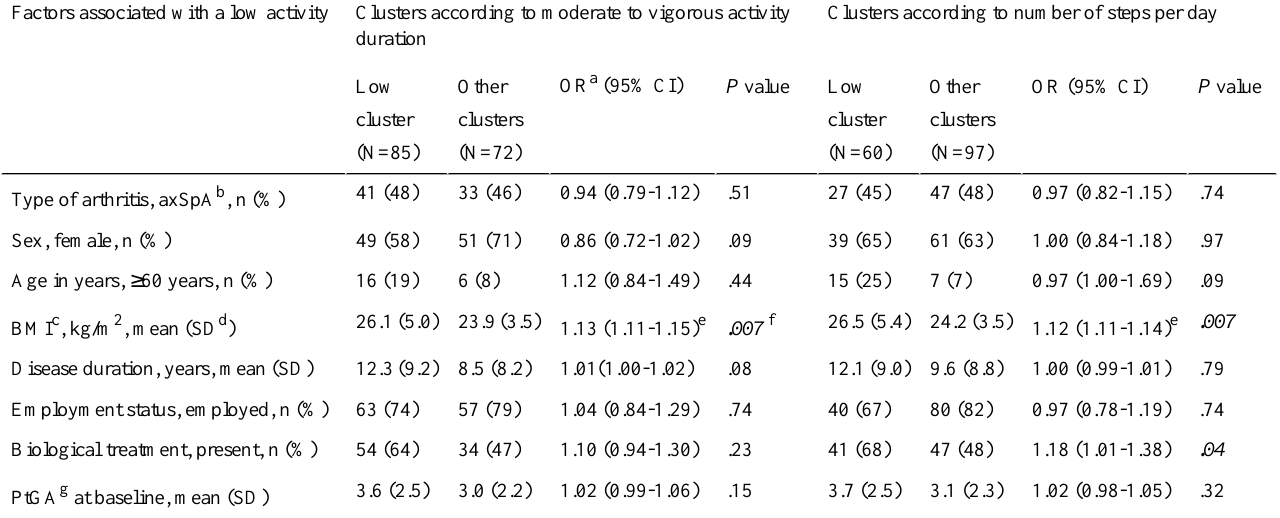
Table 3. Comparison between patients in the low activity cluster and other patients.